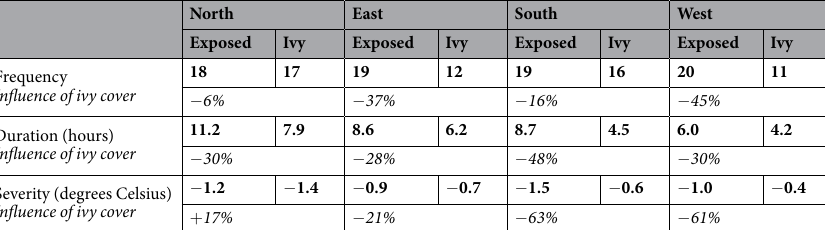
Table 1. Characteristics of freezing events recorded on test walls during winter (cumulative for 2012/13 and 2013/4) for exposed and ivy covered sections. ‘Frequency’ is the number of fluctuations below and above 0 °C; ‘duration’ is average time (in hours) temperatures fell below 0 °C per freezing event; ‘severity’ is the average minimum temperature (in °C) reached per freezing event. The influence of ivy relative to exposed stone (% difference) is